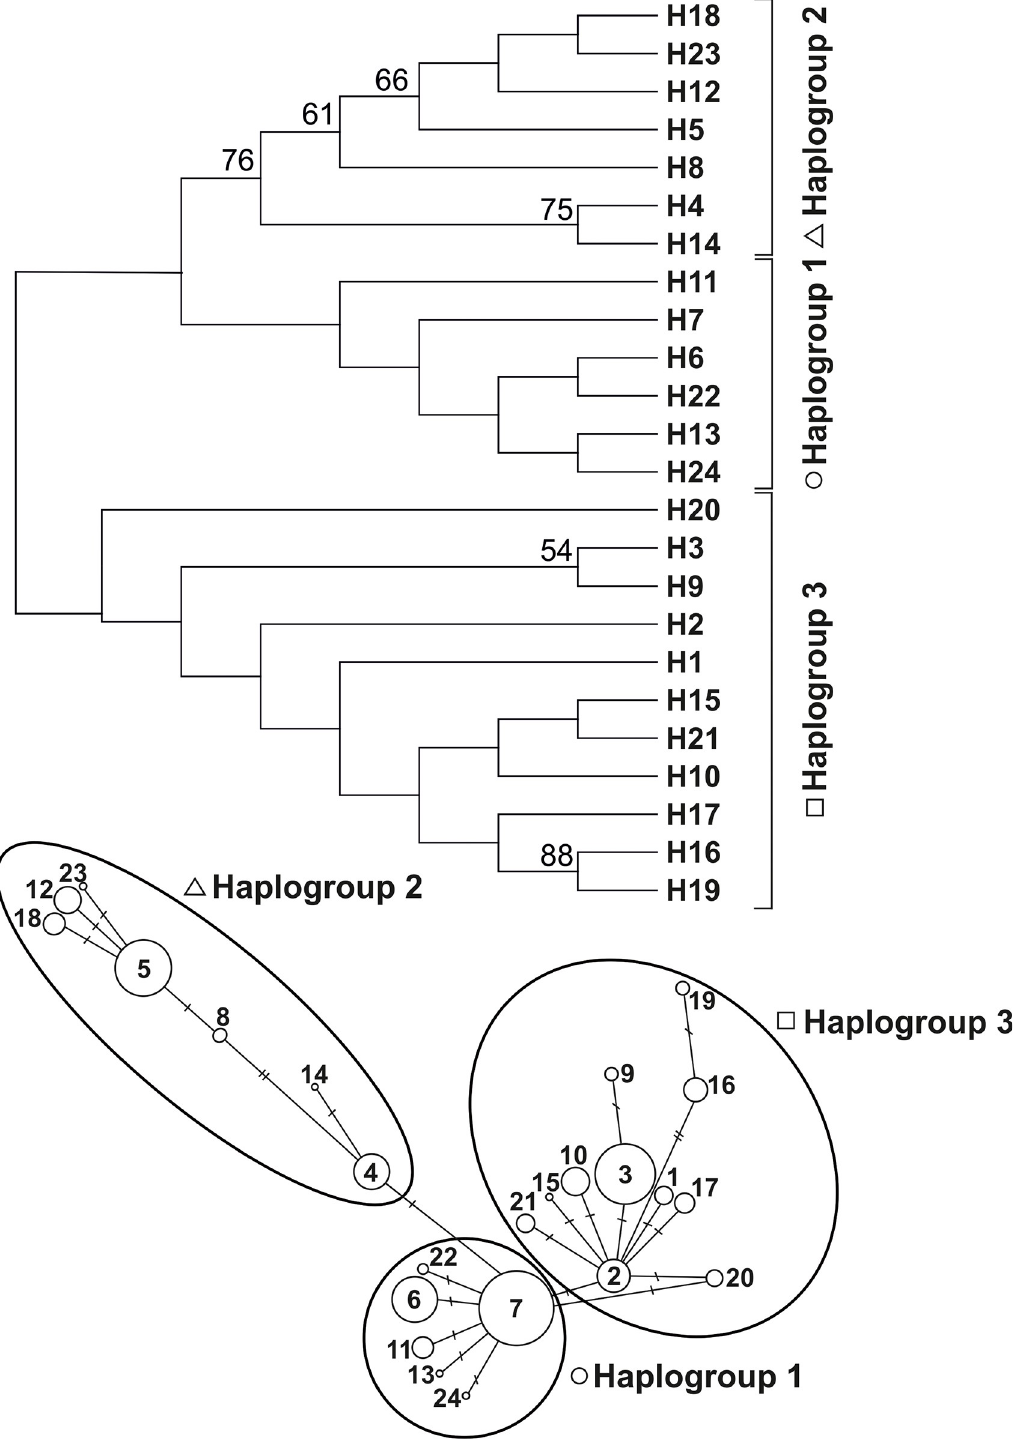
Fig 2. Upper panel: Neighbour–joining tree phylogenetic tree of cyt b fragment of mtDNA haplotypes of yellow-necked mouse found in this study. Lower panel: Median joining network constructed in program NETWORK. Dashes denote number of mutation steps among